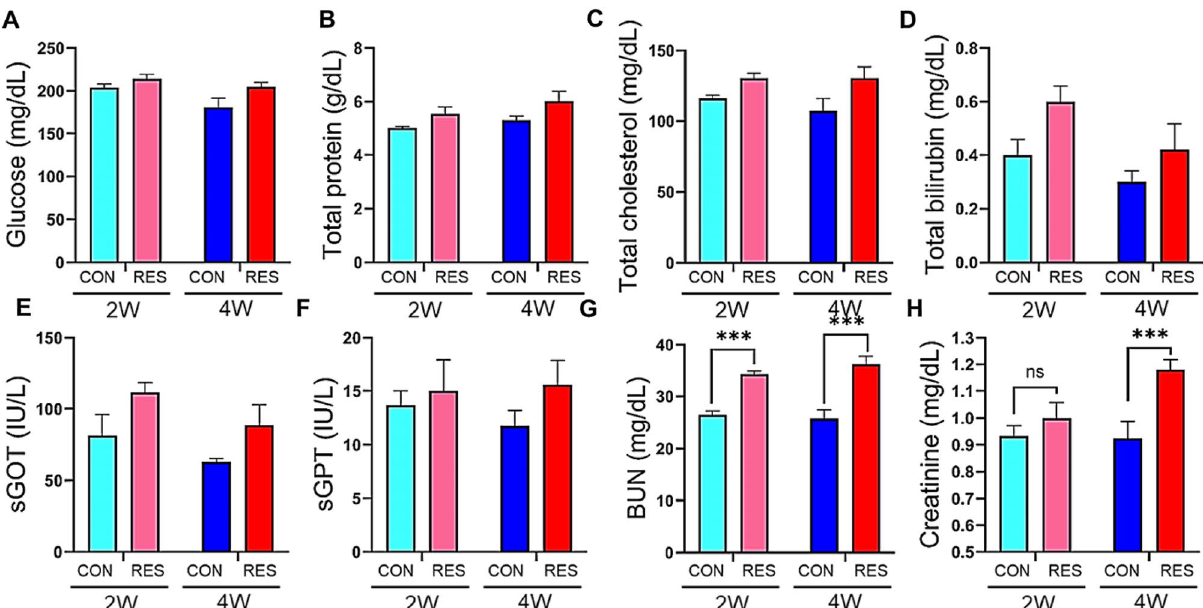
Figure 3. Changes in blood biochemical parameters following prolonged dehydration. ( A ) Glucose, ( B ) Total protein, and ( C ) Total cholesterol levels (n = 10 mice/group). Additionally, biochemical parameters for liver function, such as Total bilirubin ( D ), sGOT ( E ), and sGPT ( F ), and for kidney function, such as BUN ( G ) and Creatinine ( H ), in serum were measured (n = 10 mice/group). Data are expressed as means ± SEM. Statistical significance was calculated using a two-tailed Mann–Whitney test. * p < 0.05, ** p < 0.01, *** p <